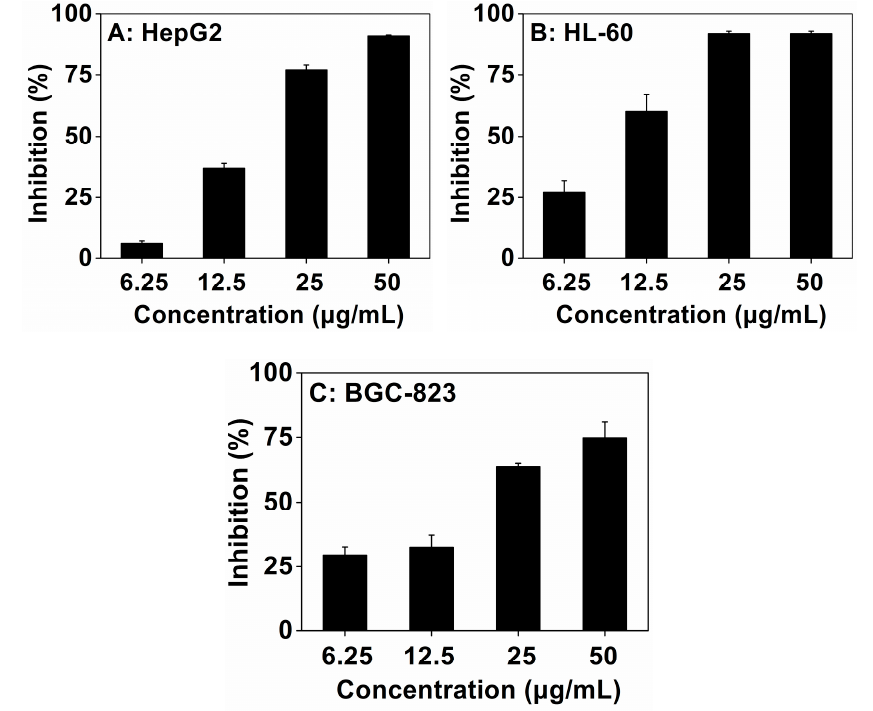
Figure 4. Effect of purified bergamottin on the growth of three cancer cell lines. Human liver cancer HepG2 ( A ); promyelocytic leukemia HL-60 ( B ); and gastric cancer BGC-823 ( C ) were used in the experiment. Taxol was used as a positive control.